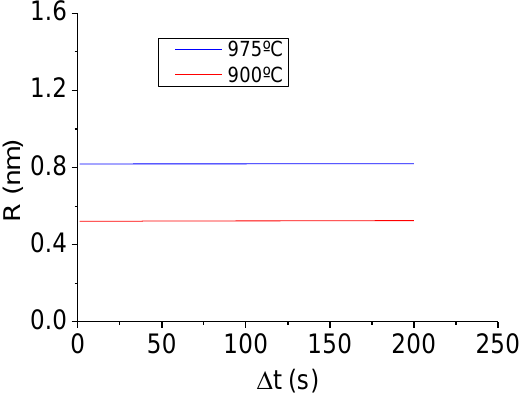
Figure 5. Precipitate size (radius) coarsening vs. time (Δ t > τ). Equation (9).